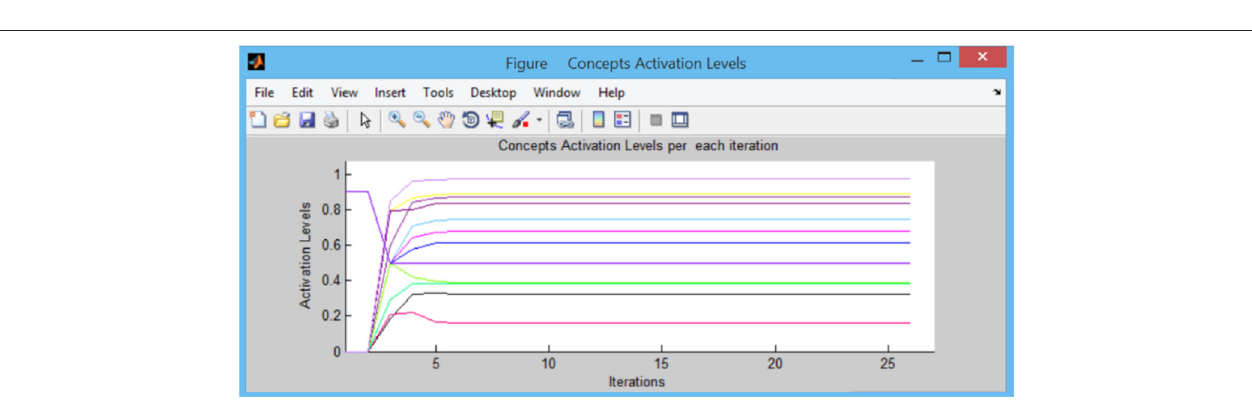
FIGURE 9 | The effect of the driver concepts in the Social_FCM for the best case scenario compared to the steady state.